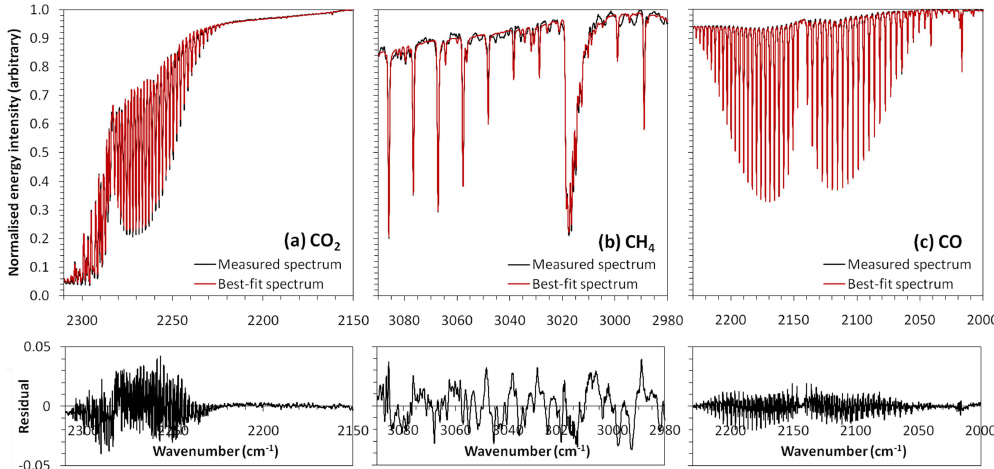
Fig. 8. Examples of measured spectra and best-fit modelled spectra made using the optimum spectral windows and a fourth-order polynomial background (top), and the residual between the measured and modelled spectra (bottom) for (a) CO 2 ; (b) CH 4 ; and (c) CO. Modelled spectra were simulated using MALT and the best-fit modelled spectra were found using the NLLS fitting